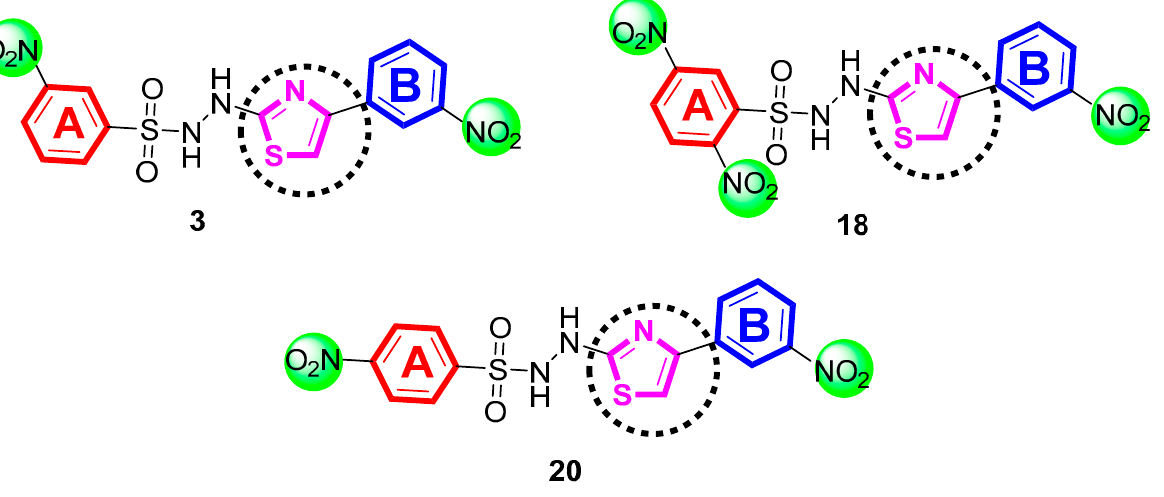
Figure 4. SAR study for scaffolds 3 , 18, and 20 .